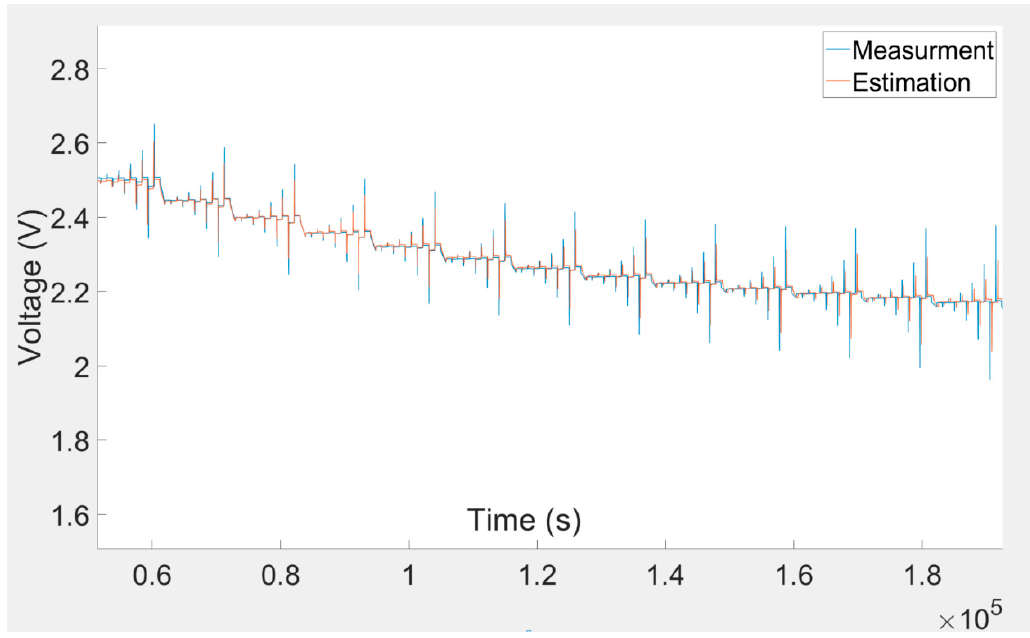
Figure 10. Comparison between experiment and simulation outcomes.